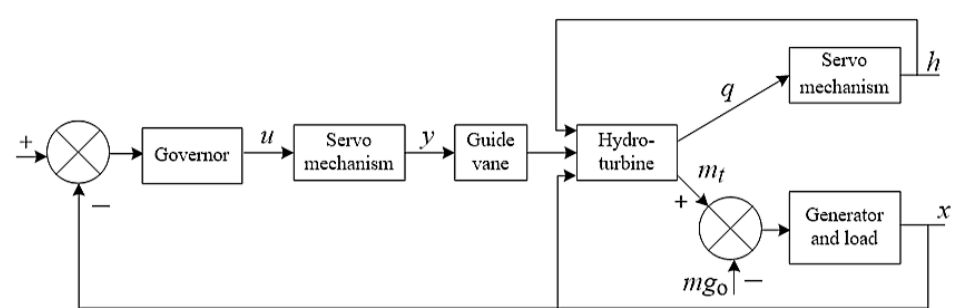
Figure 1. Structure of the hydro-turbine governing